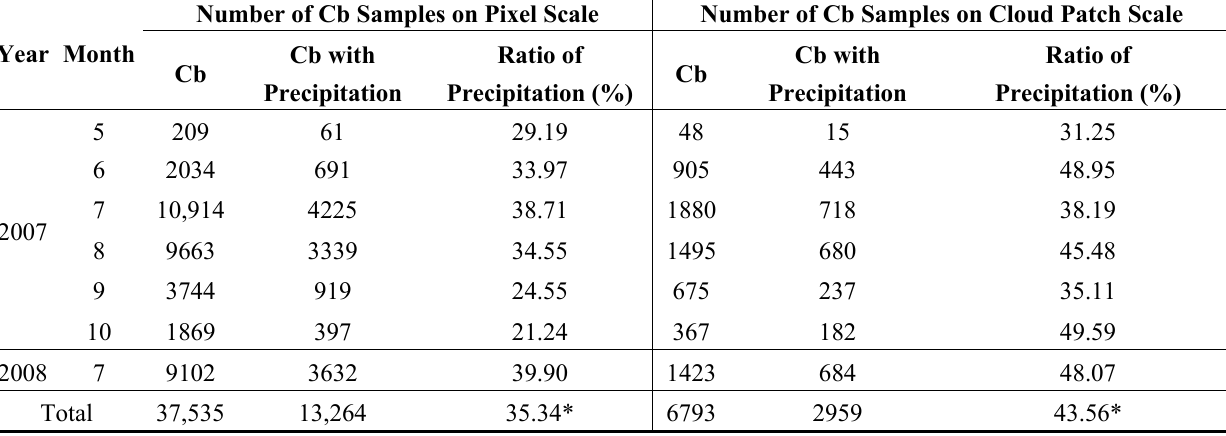
Table 3. The number of Cb samples by matching gauge rainfall observations to satellite-derived cloud